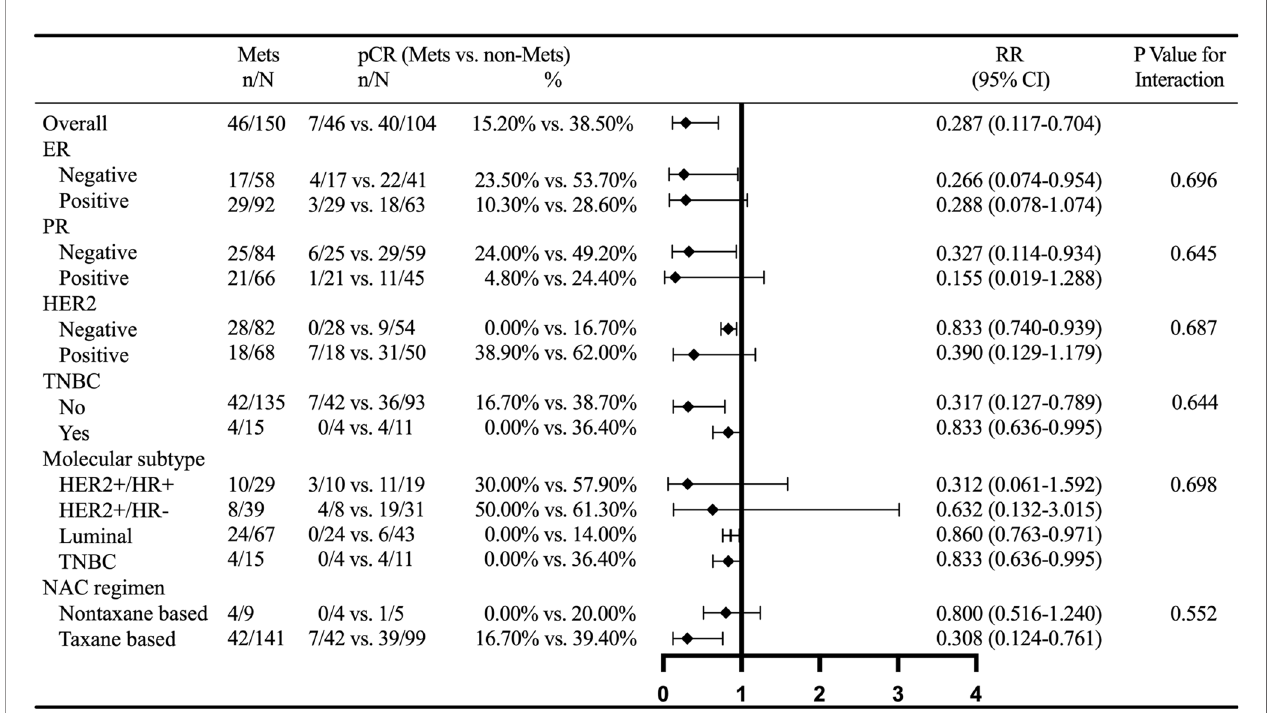
FIGURE 4 | Subgroup analysis of MetS and BCNACT pCR. MetS, metabolic syndrome; pCR, pathologic complete response; RR, risk ratio; CI, con fi dence interval; ER, estrogen receptor; PR, progesterone receptor; HER2, human epidermal growth factor 2; TNBC, triple negative breast cancer; NACT, neoadjuvant chemotherapy.